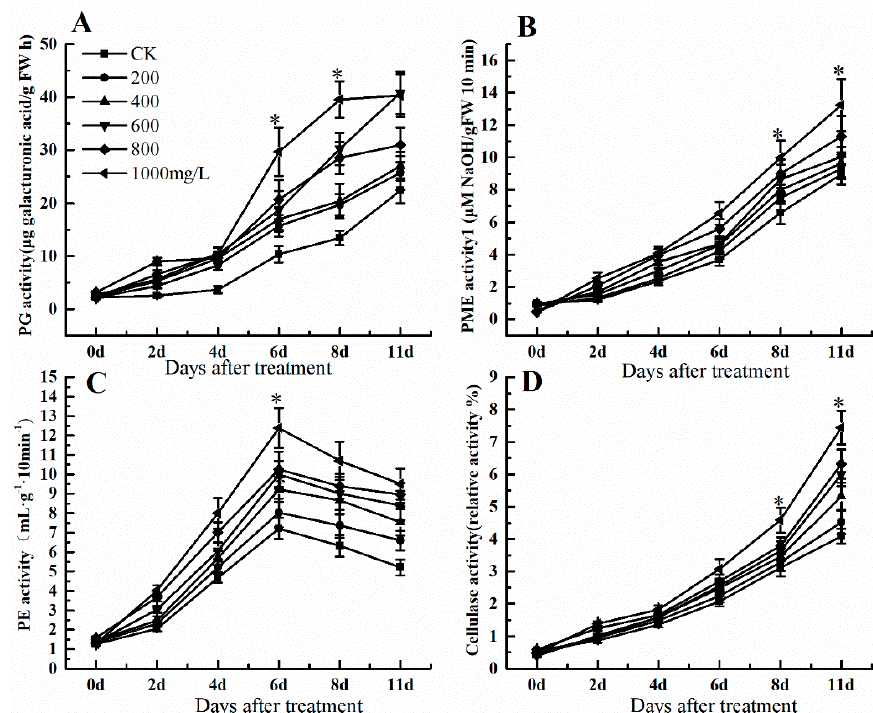
Figure 3. Effect of ethephon on cell wall metabolism-related enzyme activities in grape. ( A ) Polygalacturonase (PG) activity. ( B ) Pectin methylesterase (PME) activity. ( C ) Pectinesterase (PE) activity. ( D ) Cellulase activity. Ethephon was used in different concentrations (200, 400, 600, 800, and 1000 mg/L) and in a time course experiments (2, 4, 6, 8, and 11 days). Values are means ± SD of five biological replicates. * Significant differences compared with the control (water-treated fruits) sample at p < 0.05, using Student’s test.